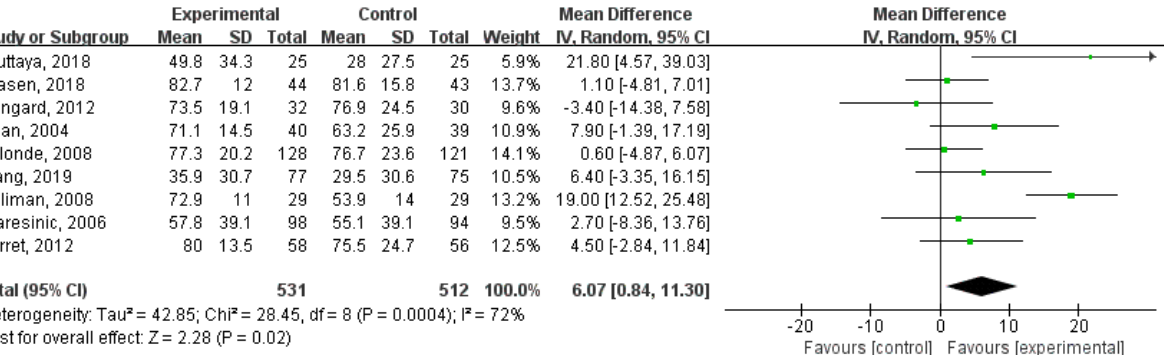
Figure 3. Results of a meta-analysis of the effects of technology-based interventions on time within target international normalized ratio range in oral anticoagulation management. IV: independent variable. Random: random effect model.